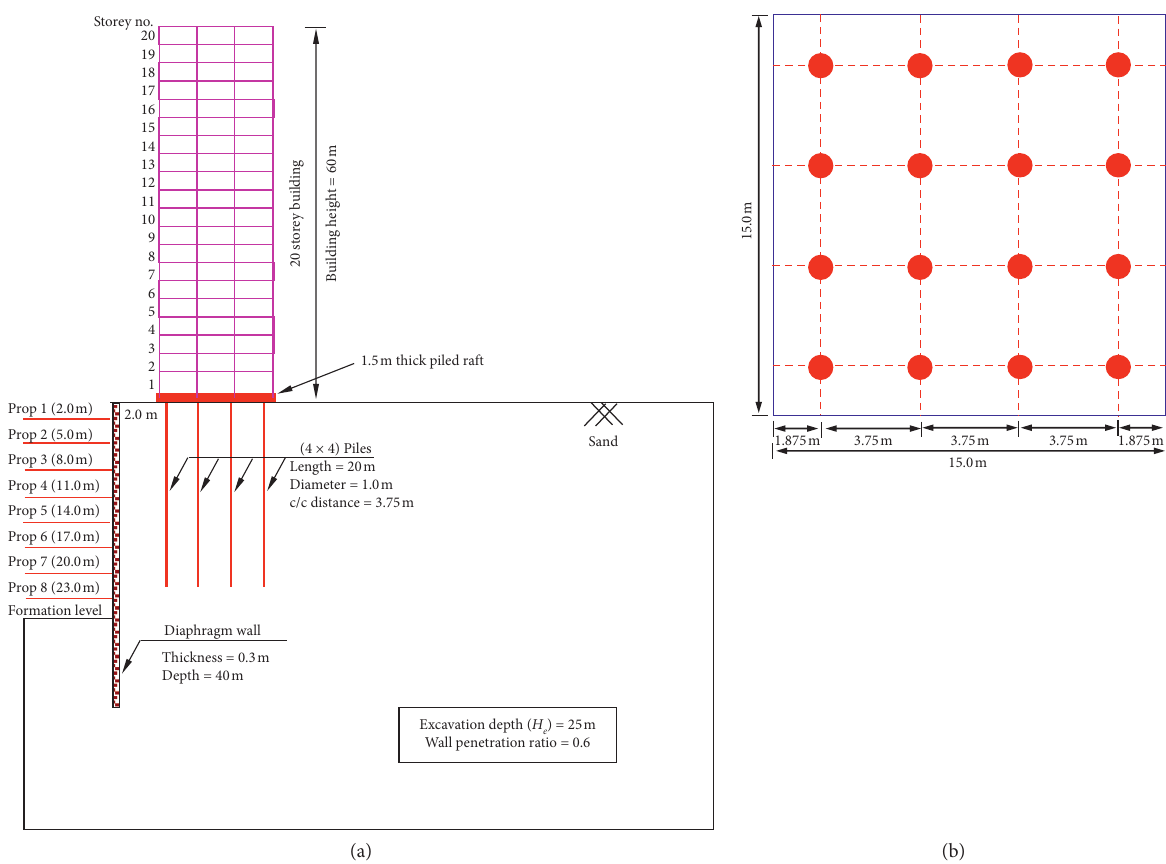
Figure 1: (a) General setup of building, piled raft, and excavation. (b) Piles arrangement in the